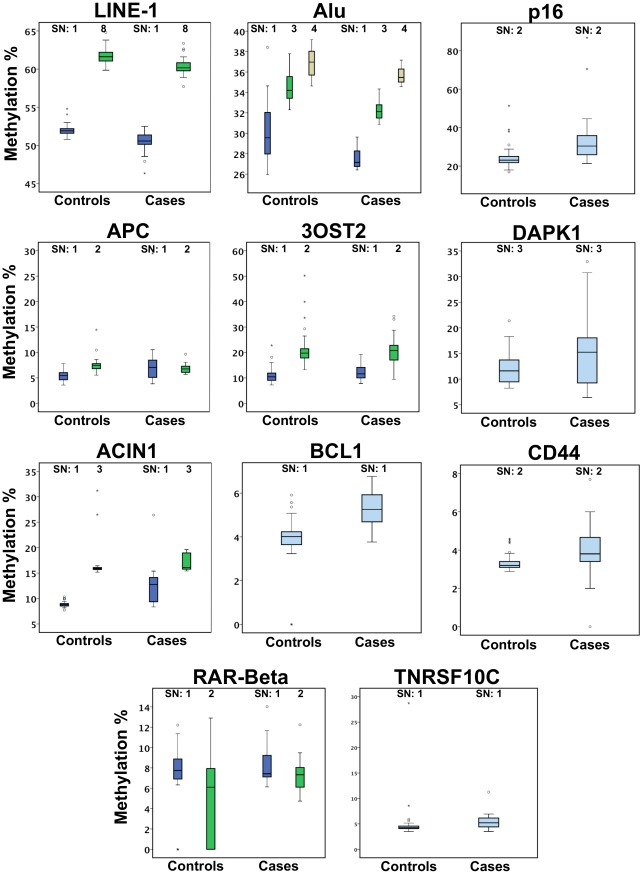
Distribution of various CpGs relative methylation levels in peripheral blood.Boxes extend from 25th to 75th percentiles and are divided by a solid line representing the median of each group. Whiskers extend from 5th to 95th percentiles. Each outlier is denoted by a dot.